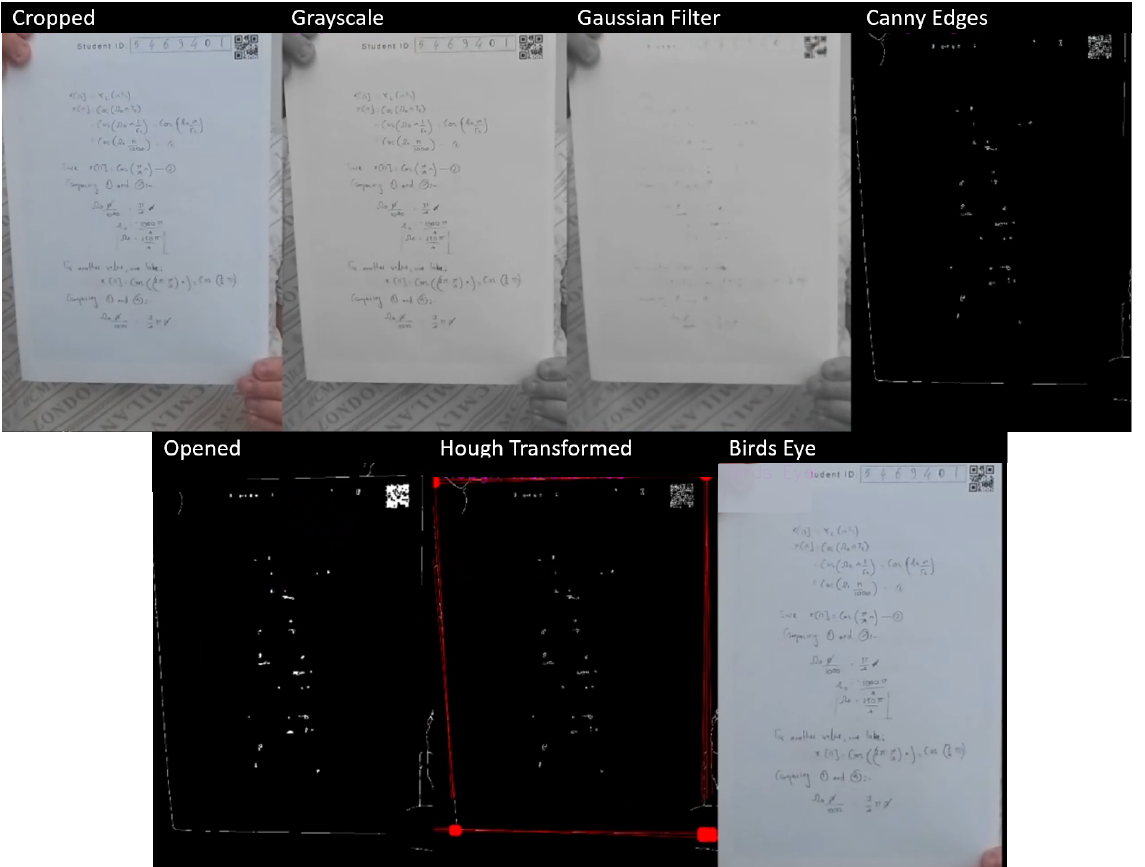
Figure 11. ID detection algorithm pipeline.